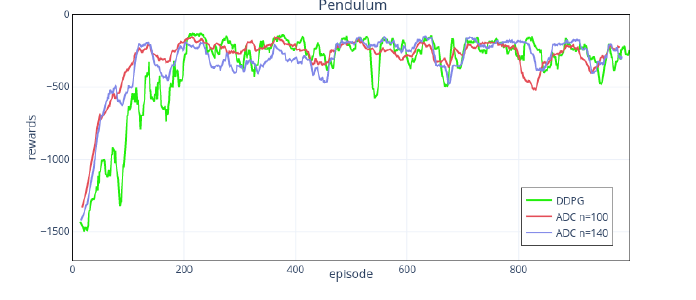
Figure 9. ADC and DDPG’s performance on Pendulum-v0 environment with noise input. The action intervals of ADC network are 20, 60, respectively. When n is 20, ADC has a limited promotion compared with DDPG. When n is 60, the convergence speed and stability have been greatly improved.